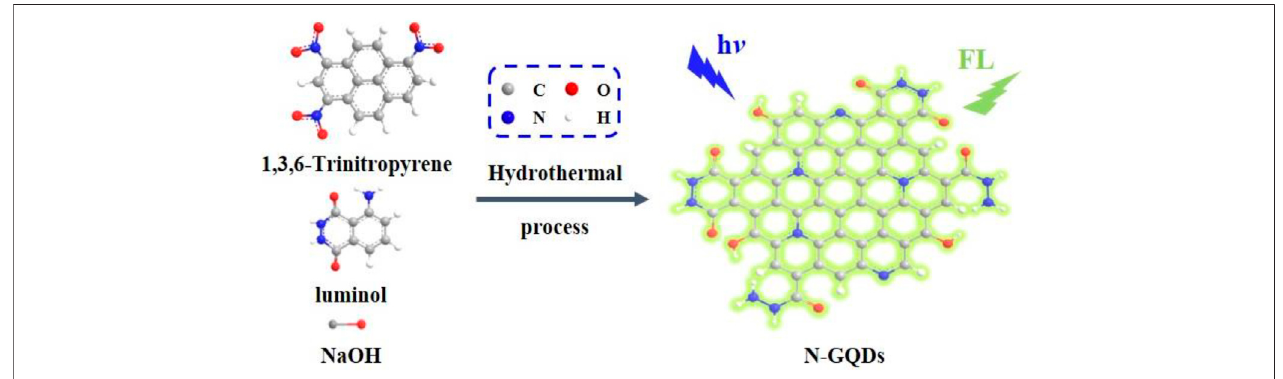
FIGURE 1 | Schematic illustration for one-step preparation of fl uorescent N-GQDs using molecular fusion in the hydrothermal